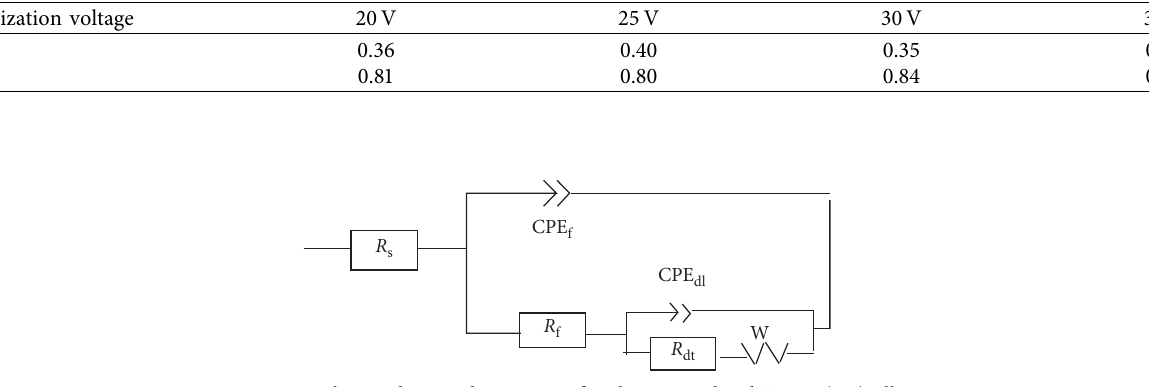
Figure 11: log ( z ) against log (frequency) for sample anodized at 20V in 5M phosphoric acid. Table 1: α 1 and α 2 values resorted from slopes of log (z) against log (frequency) at different anodization voltages.